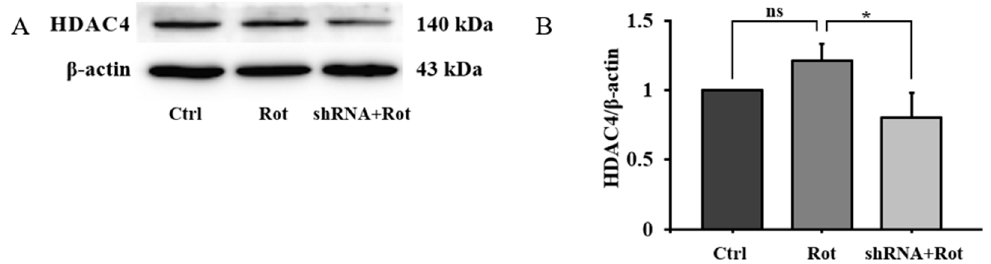
Figure 4. HDAC4 was knocked down in SH-SY5Y cells. SH-SY5Y cells transfected with HDAC4 shRNA or control shRNA were exposed to 1 µM of rotenone or vehicle for 48 h. HDAC4 levels were detected through Western blot analysis. ( A , B ) HDAC4 shRNA significantly reduced depression levels of HDAC4 in SH-SY5Y cells. * p < 0.05. ns., non-significant. Ctrl., control. Rot., rotenone.